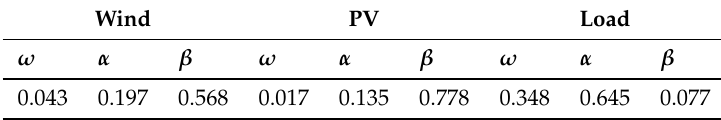
Table A2. Parameter of GARCH(1,1) models for wind, pv and load, where ω is the constant, α the arch coefficient and β the garch